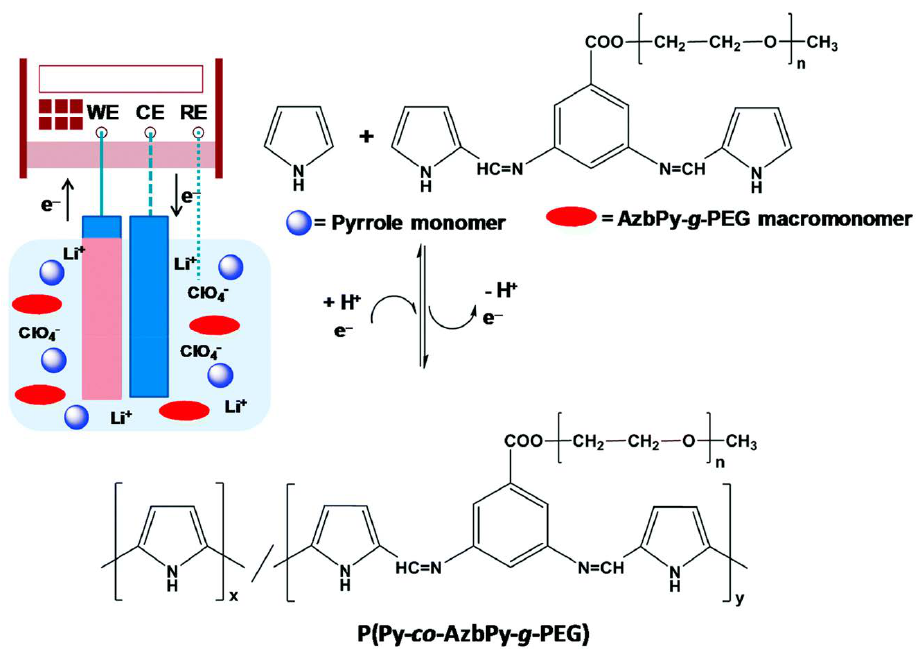
Figure 6. Scheme illustrating the anodic polymerisation of P(Py- co -AzbPy- g -PEG). Reprinted with permission from Reference [82]. Published by The Royal Society of